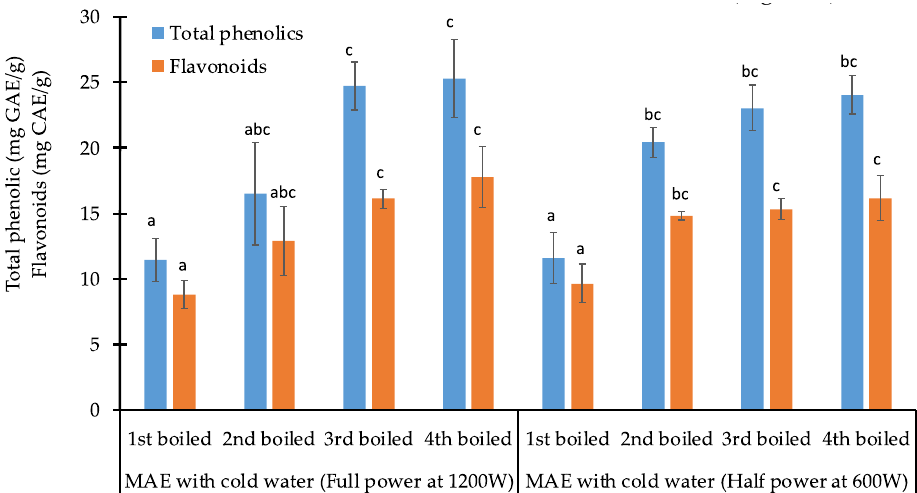
Figure 6. Extractability of total phenolic content (TPC) and total flavonoids (TFC) of herbal tea infusion prepared at different microwave assisted conditions with cold water. Data are means ± stand- ards deviations. Data for each phytochemical group (TPC or TFC) not sharing similar letters are significantly different at p < 0.05.